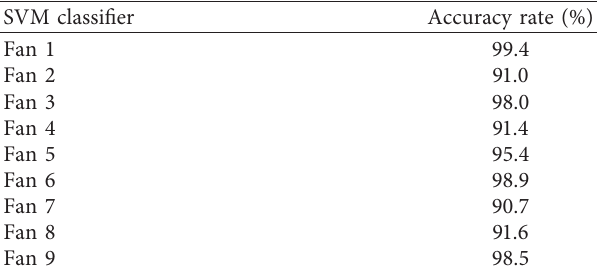
Table 2: SVM accuracy rates of each classifier related to one of the fans of the